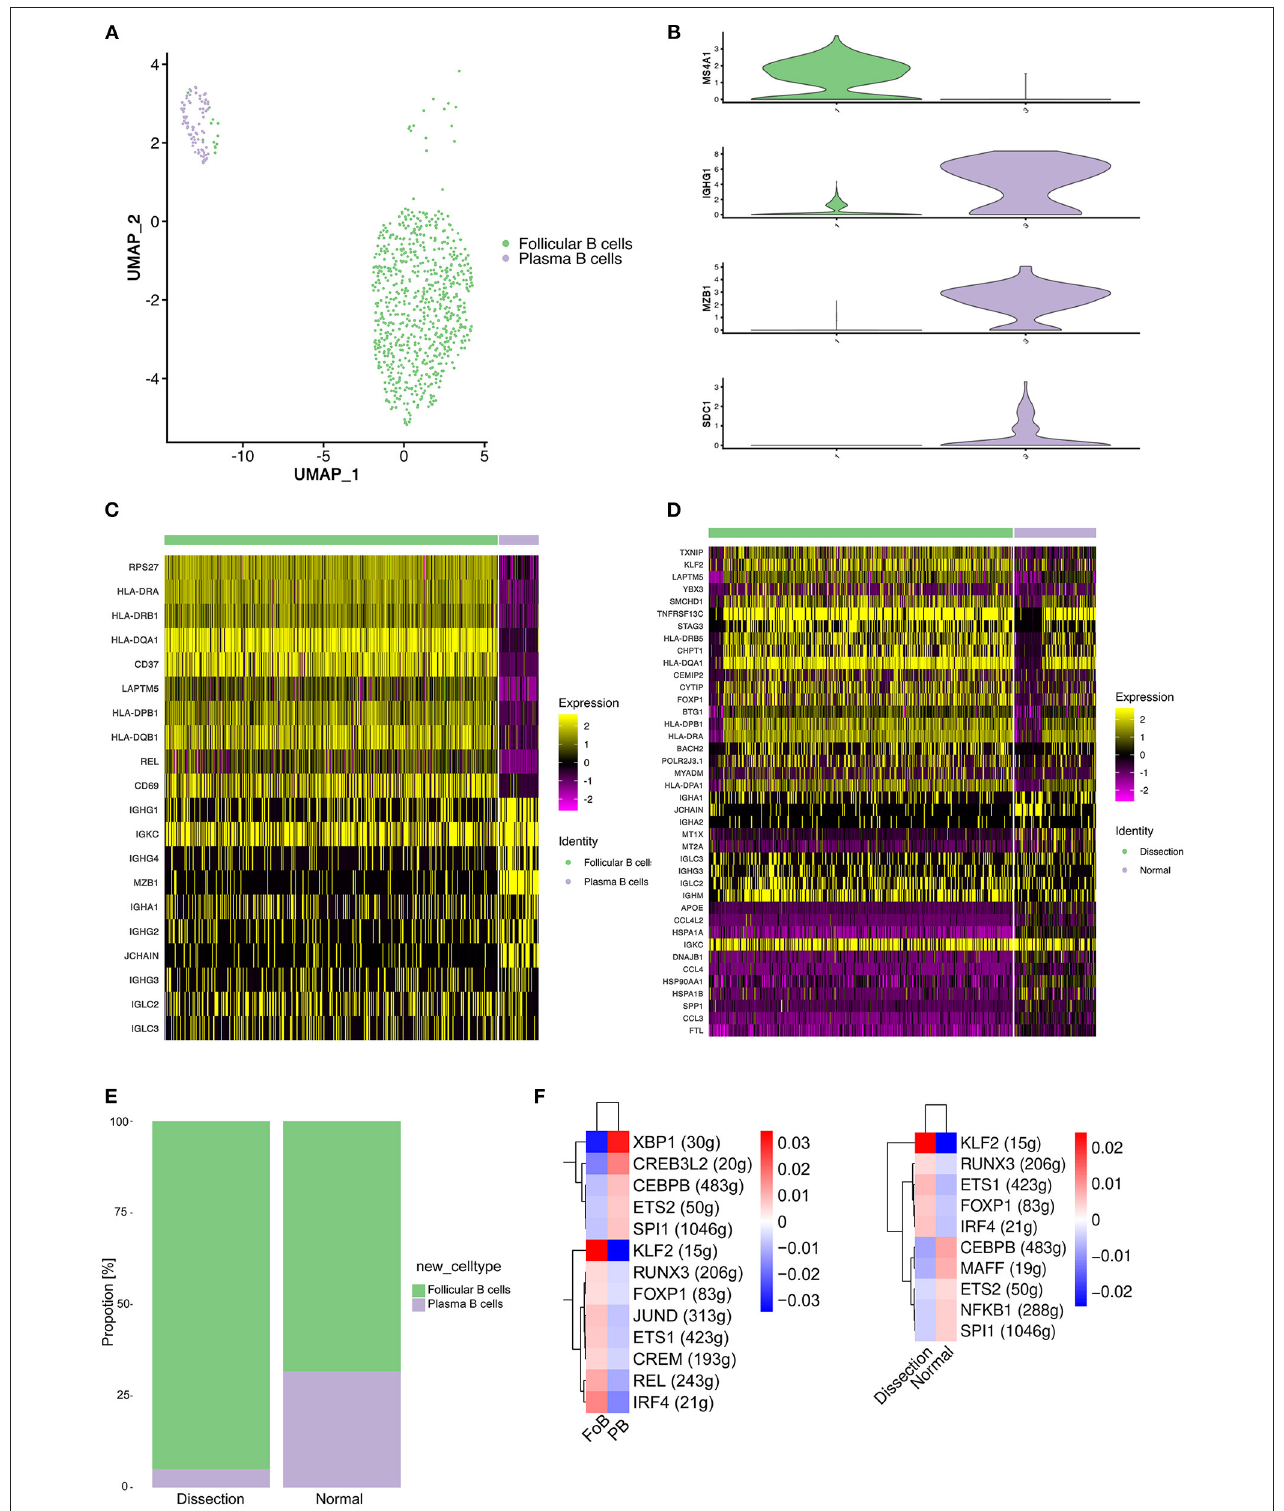
FIGURE 5 | Profiling of B cells between normal and dissected aorta samples. (A) A UMAP plot of 832 B cells reclustered into 2 clusters. (B) UMAP plots showing the expression of selected marker genes for subpopulations of B cells. (C) Heatmap of the top 10 [by average log (fold change)] marker genes in FO B cells and plasma cells. (D) Heatmap of the top 20 [by average log (fold change)] marker genes in B cells of the AD and NA groups. (E) Bar graph showing the proportion of B-cell